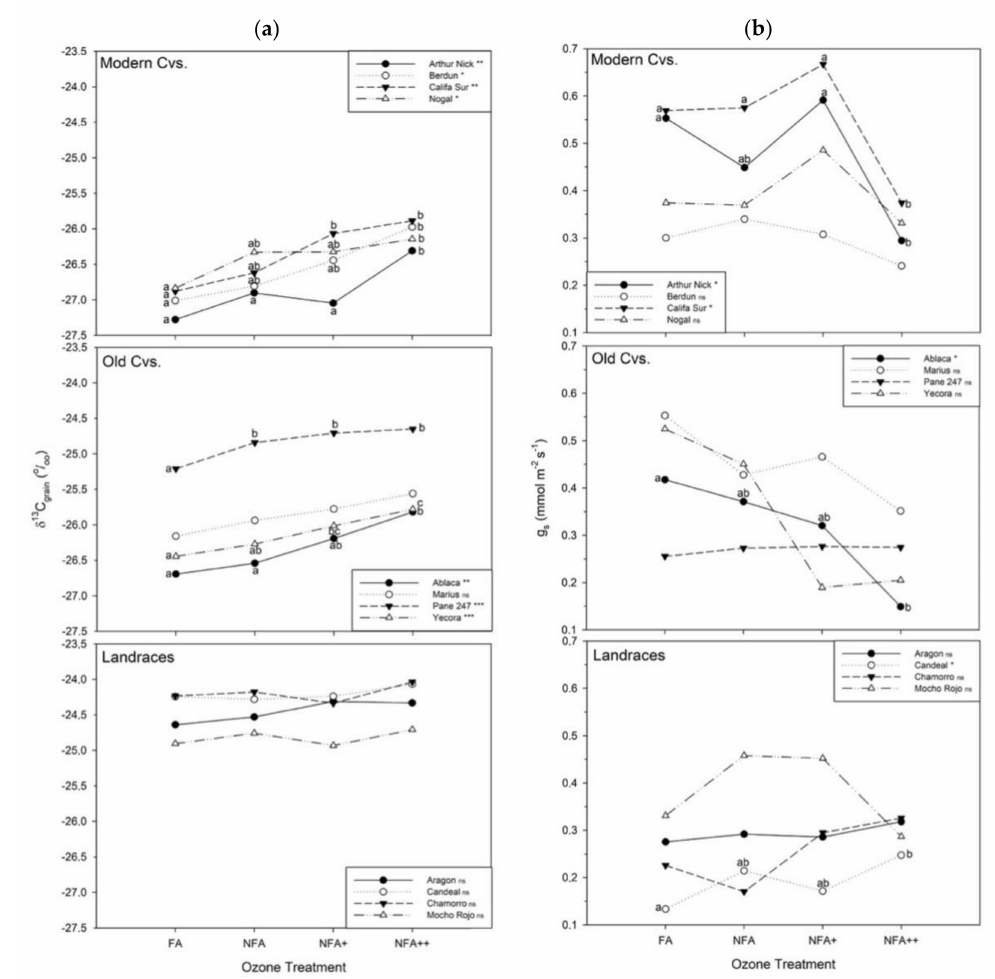
Figure 3. ( a ) Stable carbon isotope composition ( δ 13 C; ‰) of mature grains and ( b ) stomatal conductance (mmol H 2 O m − 2 s − 1 ) for the different O 3 treatments: FA = charcoal filtered air, NFA = non filtered air, NFA+ = non filtered air supplemented with 20 nL L − 1 of O 3 , NFA++ = non filtered air supplemented with 40 nL L − 1 of O 3 . Different letters indicate statistically significant differences (*** p < 0.001, ** p < 0.01, p < 0.05, ns: non-significant) between O 3 levels for each cultivar under Tukey